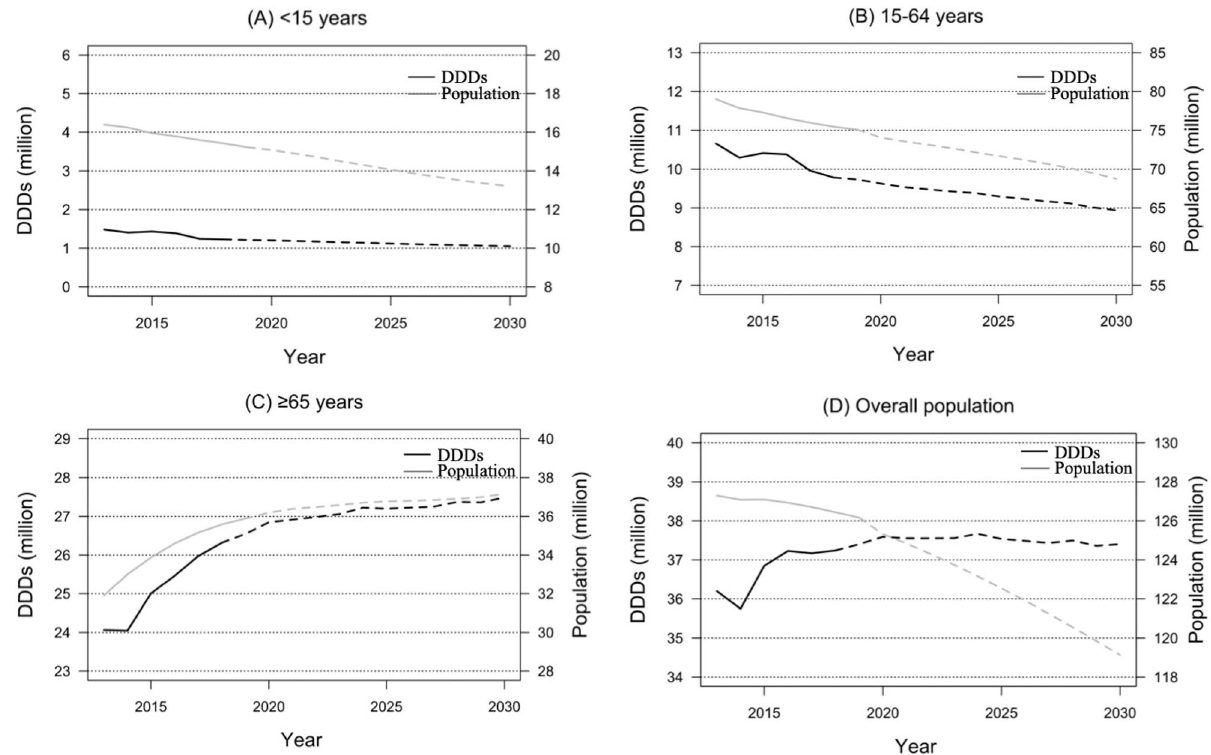
Figure 2. Trends and predictions in the DDDs of parenteral antimicrobials according to age group. ( A ) Children aged < 15 years. ( B ) Working-age persons aged 15–64 years. ( C ) Older persons aged ≥ 65 years. ( D ) Overall population. DDDs were predicted using the 2018 DID values. Solid lines represent chronological data of DDDs and population numbers from 2013 to 2018, and dashed lines represent the predicted values from 2019 to 2030 based on 2018 values. DDD, defined daily dose; DID, defined daily doses/1000